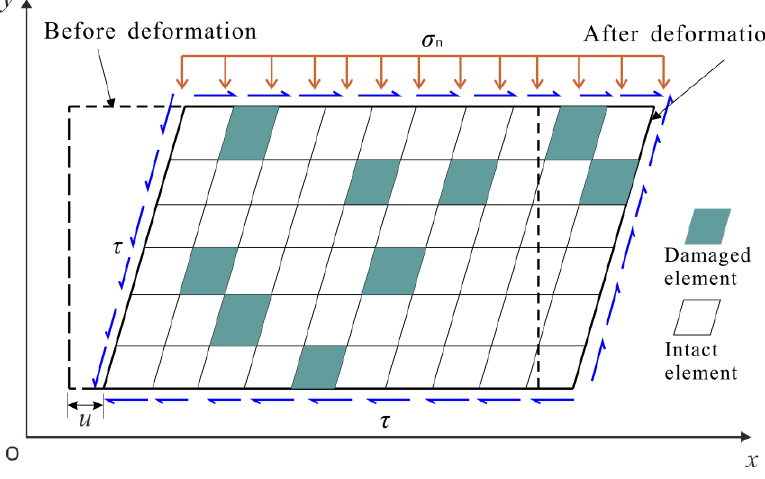
Figure 3. Damage model of soil microelement in shear process of slip zone soil .